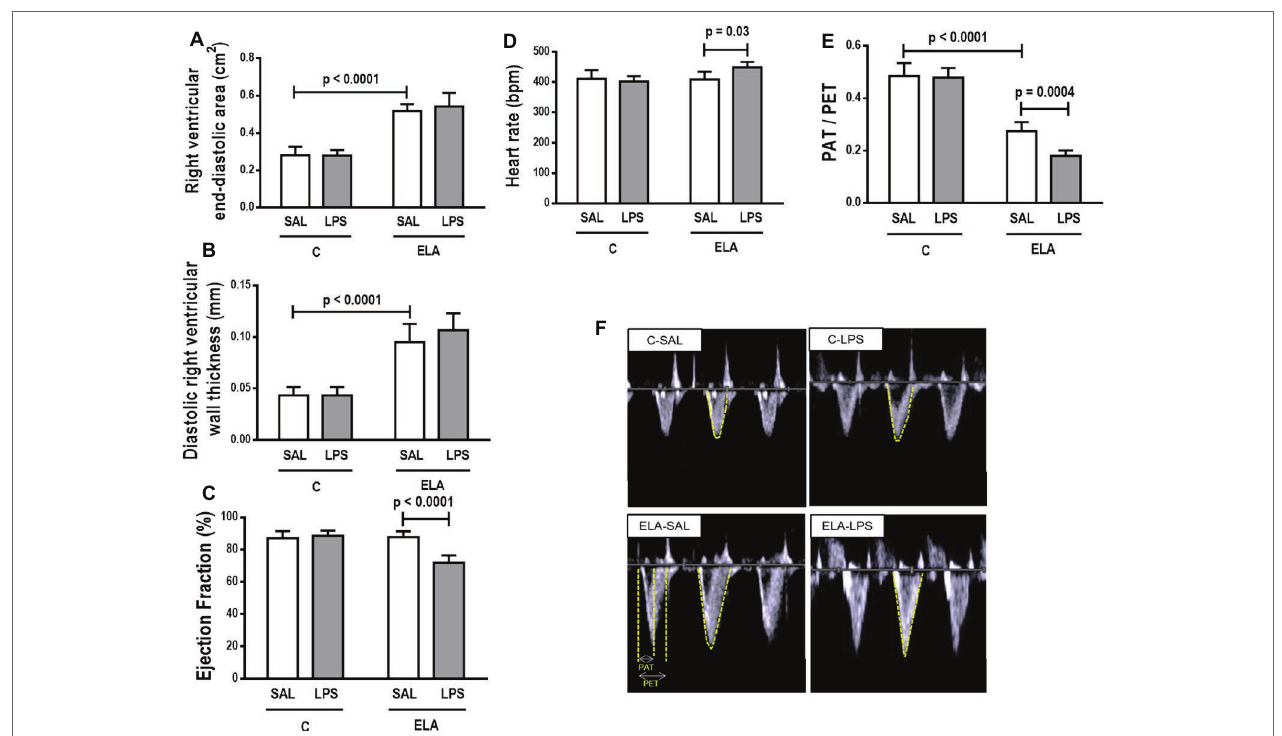
FIGURE 7 | Echocardiography. (A) right ventricular end-diastolic area, (B) diastolic right ventricular wall thickness, (C) ejection fraction, (D) heart rate, (E) PAT/PET ratio, and (F) representative images of pulmonary blood flow. C, control; ELA, animals treated with intratracheal instillations of elastase; SAL, saline; LPS, E. coli lipopolysaccharide. Values are mean ± SD of six animals in each